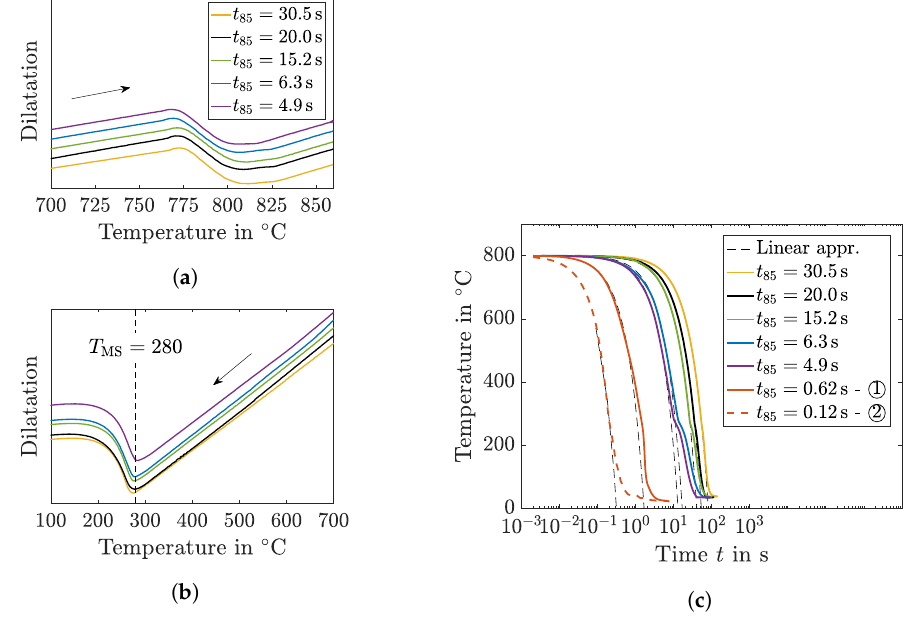
Figure 2. Heat treatment of the specimens, ( a ) dilatation curves of SAE4150 during heating, ( b ) dilatation curves of SAE4150 during cooling, ( c ) temperature profile during cooling. Note that temperature curves are time-shifted so that T ( t = 0 ) = 800 ◦ C.